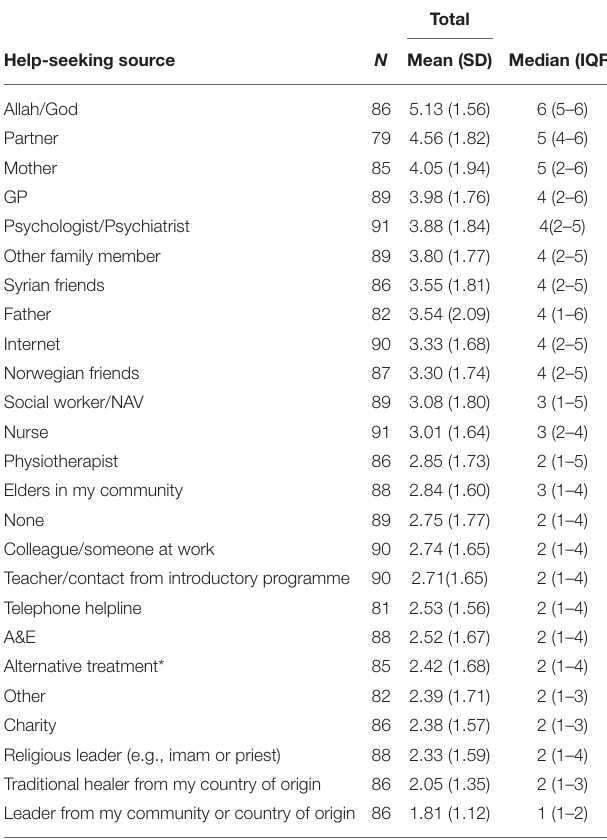
TABLE 1 | Participants’ likelihood of seeking help from different sources ordered by highest (top) to lowest (bottom) total mean likelihood score, standard deviation (SD), median, and interquartile range